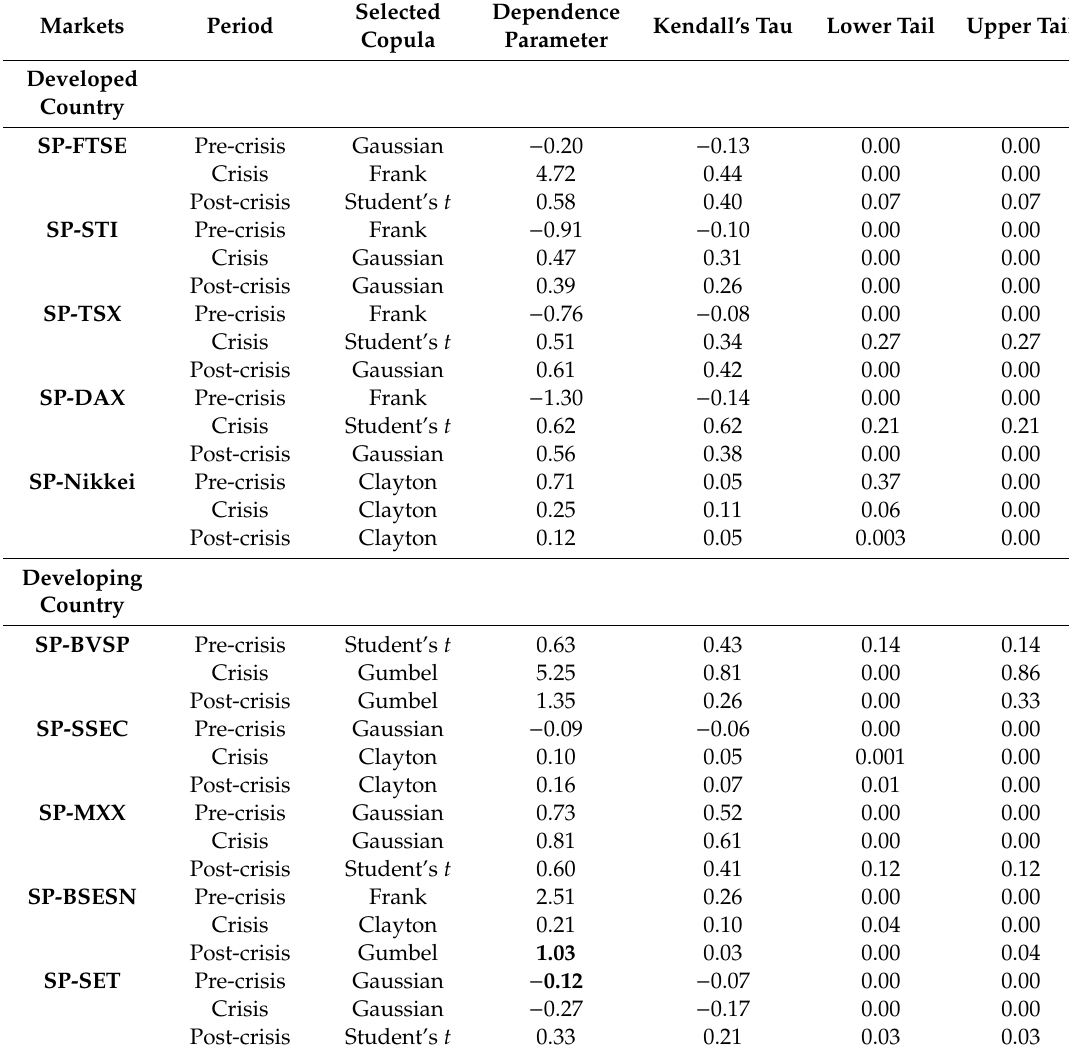
Table 5. The selected copulas for the developed and developing markets during three sub-periods. Markets